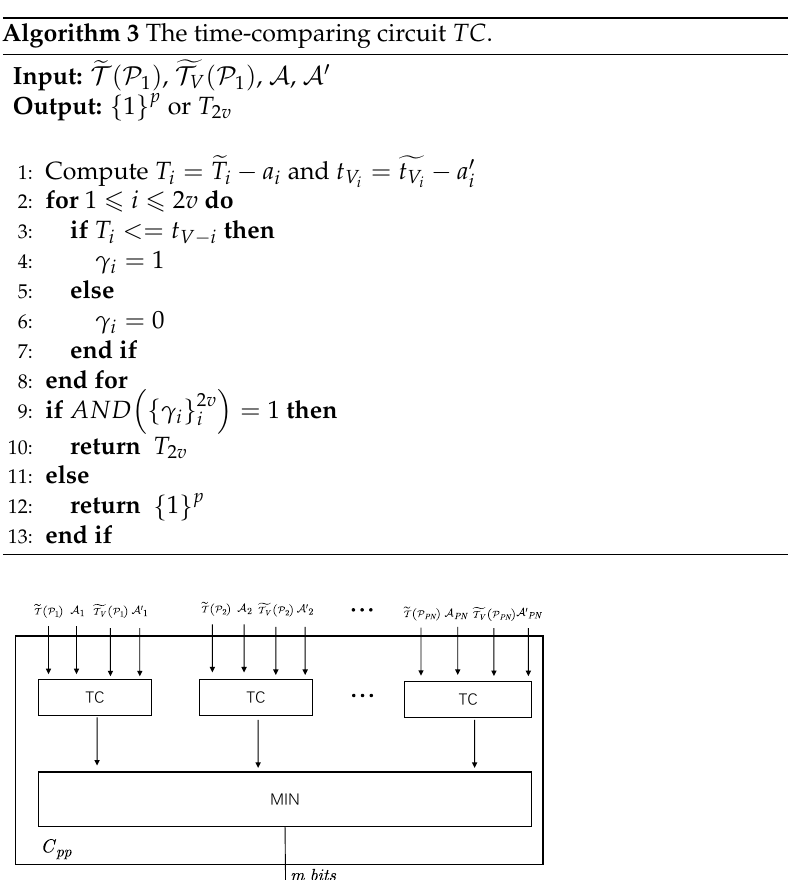
(cid:8) (cid:9) CN C j , the j = 1